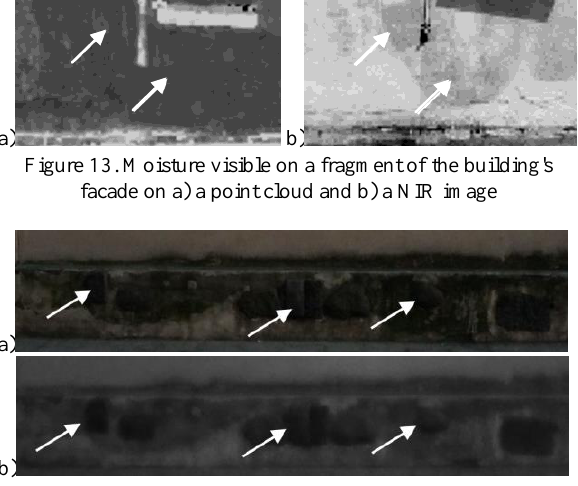
Figure 14. Moss visible on a fragment of the building's